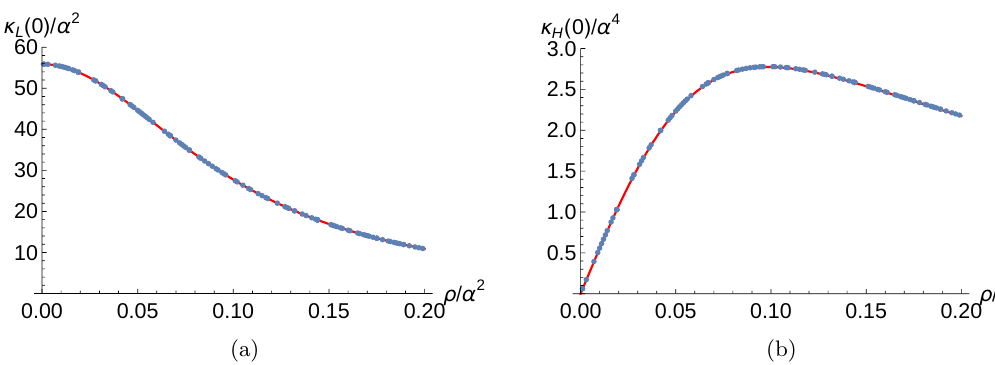
Figure 4 : Plots of the longitudinal and Hall thermal conductivites at B=(cid:11) 2 = 1 = 100 against (cid:26)=(cid:11) 2 . The blue dots represent data while the red lines are analytic expressions. The matching is generally on the order of (cid:24) 10 (cid:0) 15